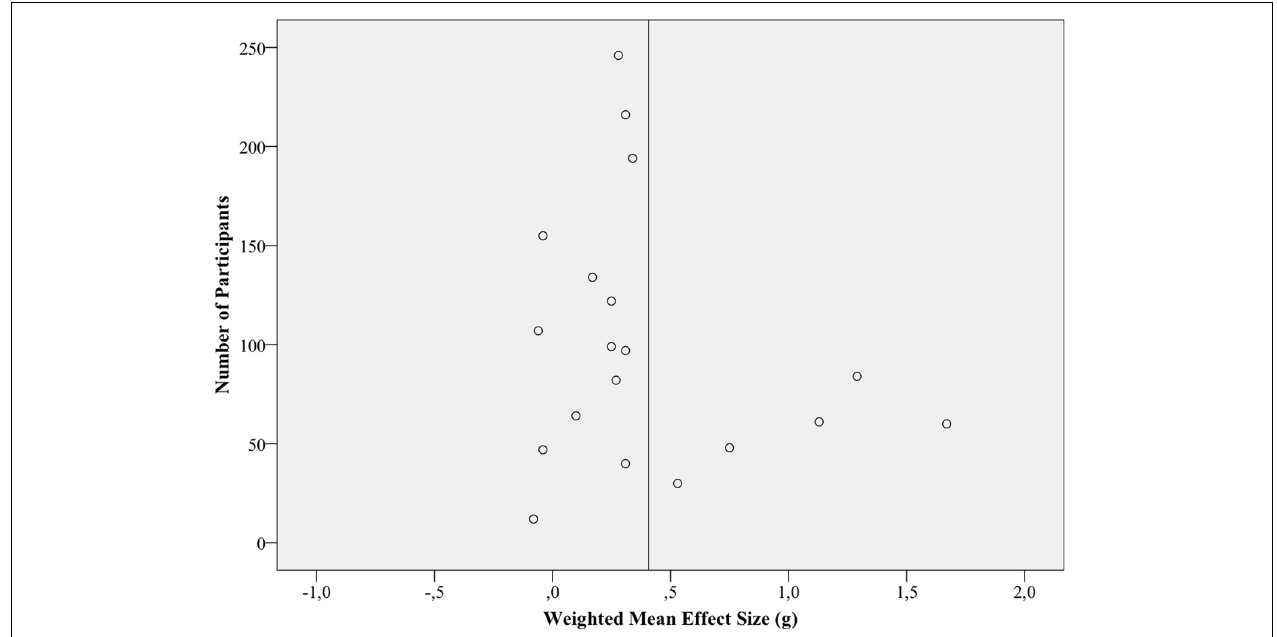
FIGURE 4 | Funnel plot of all controlled effects sizes ( K = 19). The vertical bar represents the weighted (by sample sizes) mean effect sizes.